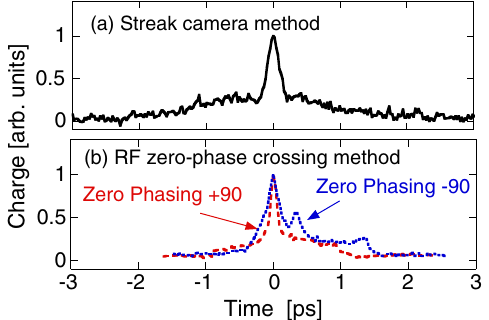
FIG. 34. Cross-check data among the electron bunch lengths measured with the streak camera (black solid line) and the rf zero-crossing methods (red and blue dotted lines). þ 90 degrees is an acceleration phase condition in the C-band traveling accelerating structures before the bunch compressor and (cid:1) 90 degrees is a deceleration phase condition. Both of the measured bunch lengths are about 300 fs in FWHM.